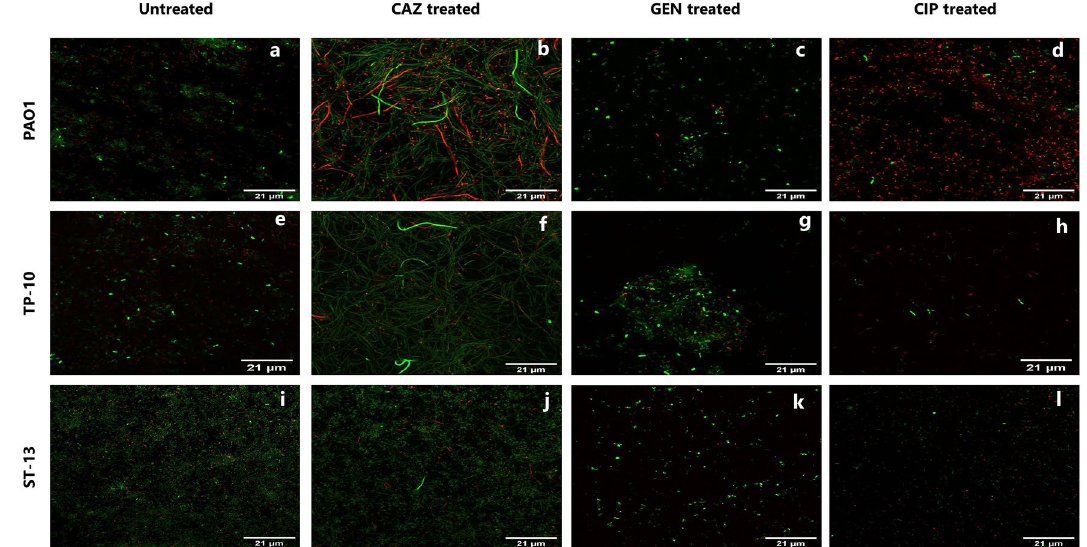
Figure 7. CLSM of PC in the biofilm stage. The representative images of PAO1, TP-10, and ST-13 biofilm, grown in MHB, after 4 h of ( a,e,i ) without antibiotic treated and antibiotic treatment with ( b,f,j ) CAZ, ( c,g,k ) GEN, and ( d,h,l ) CIP. Biofilm was rinsed with 0.85% NaCl to remove any residue of antibiotics and staining was done using RSG and PI dyes. CAZ: ceftazidime, GEN: gentamicin, and CIP: ciprofloxacin. Images were analysed using Fiji